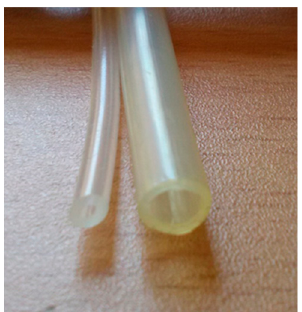
Figure 7. Tubes with small and large section used in the experiments.